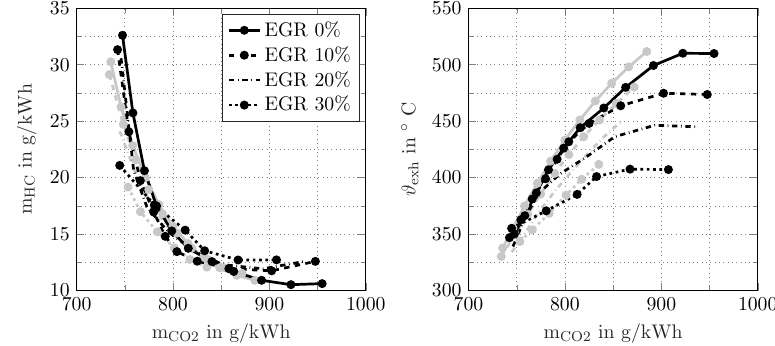
Figure 9. Measured (black) HC and CO 2 emissions for a sweep of the equivalence ratio φ performed for various EGR rates at a fixed brake mean effective pressure p me = 3.19 bar. The corresponding modeled values are outlined in